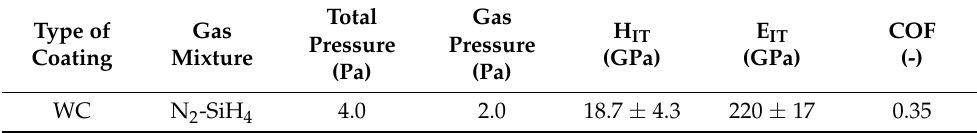
Table 1. The technological parameters of the WC/C coating deposition using the PE CVD method using hexacarbonyl of W as the precursor and the selected mechanical properties of the obtained coating before annealing.